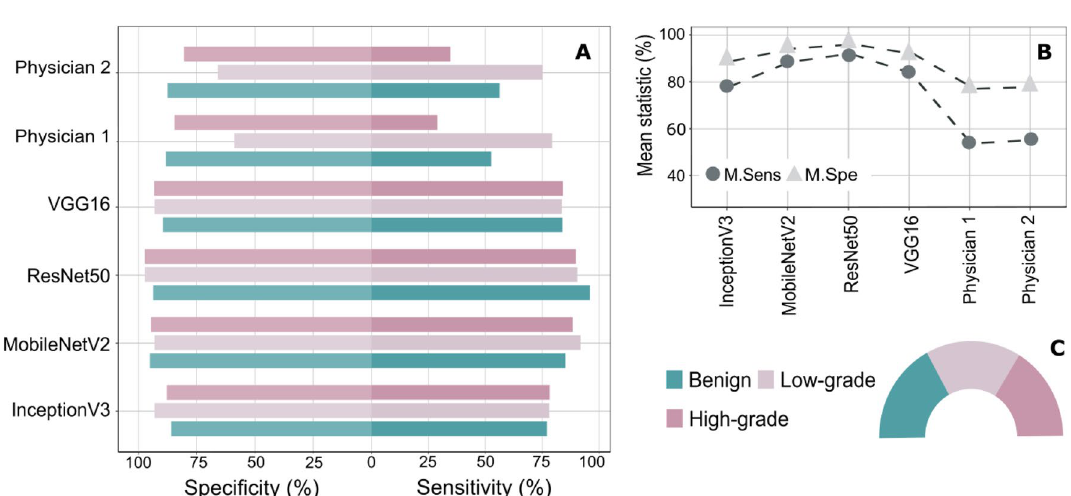
Figure 3. The classification results of bladder cancer grading. ( A ) Overview of the individual class sensitivity and specificity with respect to both physician ratings and the fine-tuned CNNs. ( B ) Summary plot of the mean sensitivities and mean specificities obtained by the fine-tuned CNNs and both physician’s ratings. An increase between 25 and 40% of the classification mean sensitivity can be observed if the fine-tuned CNNs were considered to identify bladder cancer grading based on the collected BL images. ( C ) Image class distribution with respect to the whole data size. Almost similar number of images were acquired from benign, low-grade, and high-grade